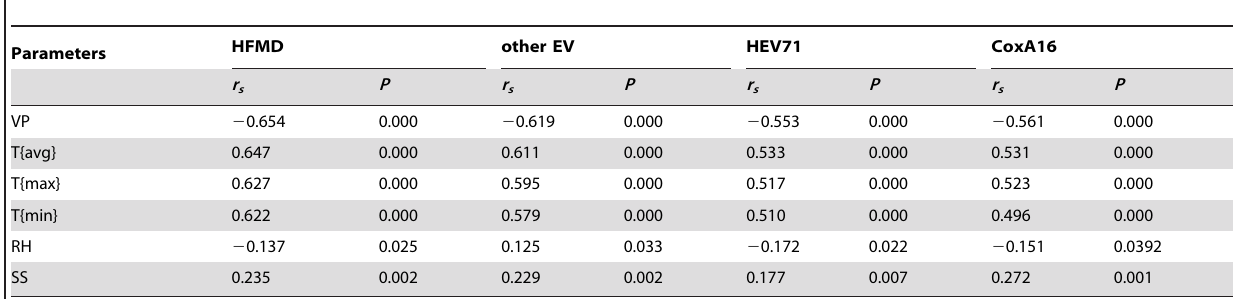
Table 2. Spearman rank correlation coefficients for the associations between meteorological parameters and hospitalizations of children with